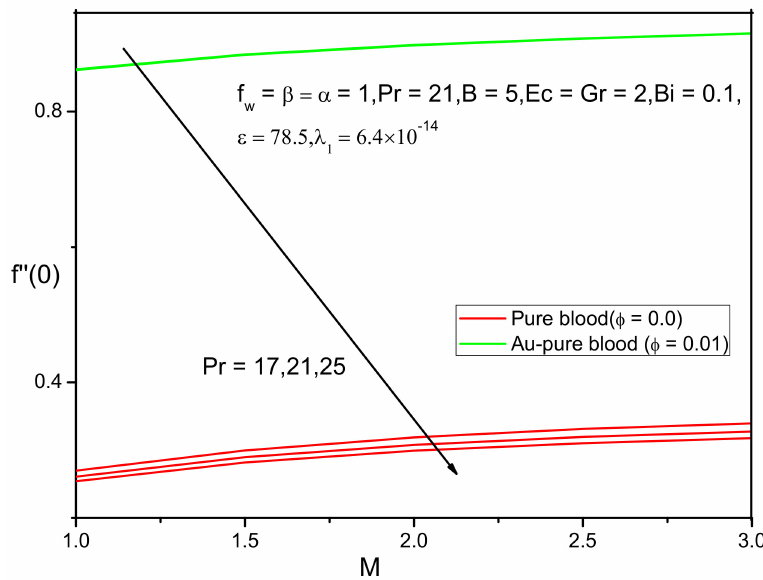
Figure 24. Skin friction coefficient f (cid:48)(cid:48) ( 0 ) with M for different values of Pr.